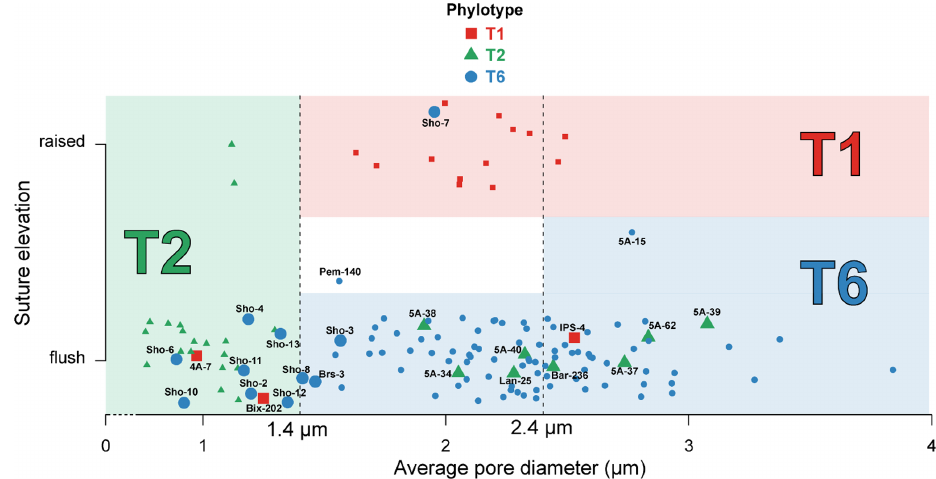
Figure 3. Average pore diameter (µm) and suture elevation (flush or raised) for the 137 individuals investigated morphologically. Individuals genotyped as T1 (red squares), T2 (green triangles) and T6 (blue circles) are represented in the graph which separates the three phylotypes on the basis of their average pore diameter and suture elevation following Richirt et al. (2019a) (red area for T1, green area for T2 and blue area for T6). Individuals for which genetic and morphological identification are mismatching, or are discussed in the text, are represented by bigger marks and associated with their IDs (see Supplement). Pem-140 was too damaged to be morphologically determined regarding the suture elevation (white area); 5A-15 is the only specimen for which we used criterion (3) of the dichotomous procedure indicated in Fig. 1. The (random) vertical dispersion was artificially added in order to better visualize all specimens separately. Vertical dotted lines represent the thresholds to discriminate between the phylotypes as determined by Richirt et al. (2019a). Table 3. Location, geographic coordinates and number of individuals genetically identified as T1, T2A, T2B and T6 at the sites of the AMTEP